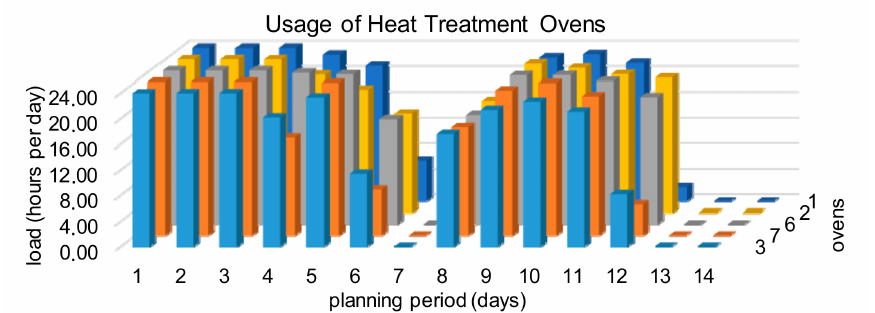
Figure 6. Total furnace